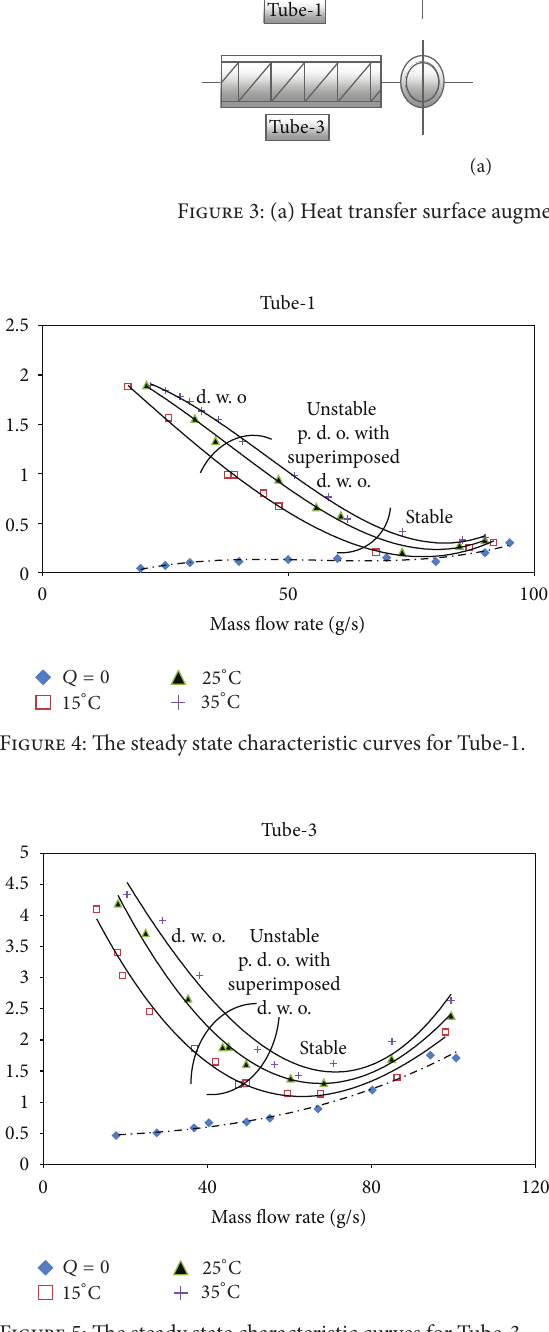
F 5: e steady state characteristic curves for Tube-3.